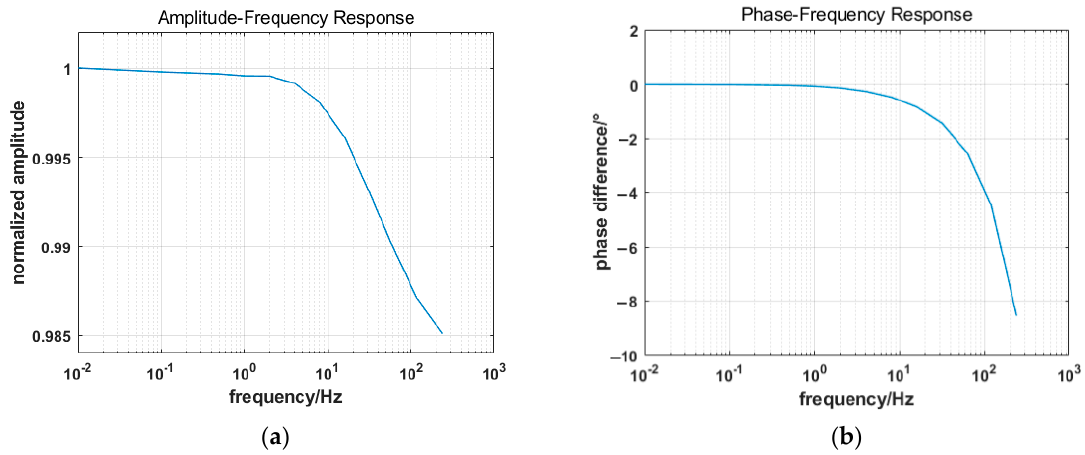
Figure 4. Amplitude–frequency and phase–frequency characteristic curves of the fluxgate magne- tometer: ( a ) amplitude–frequency characteristic curve; ( b ) phase–frequency characteristic curve.